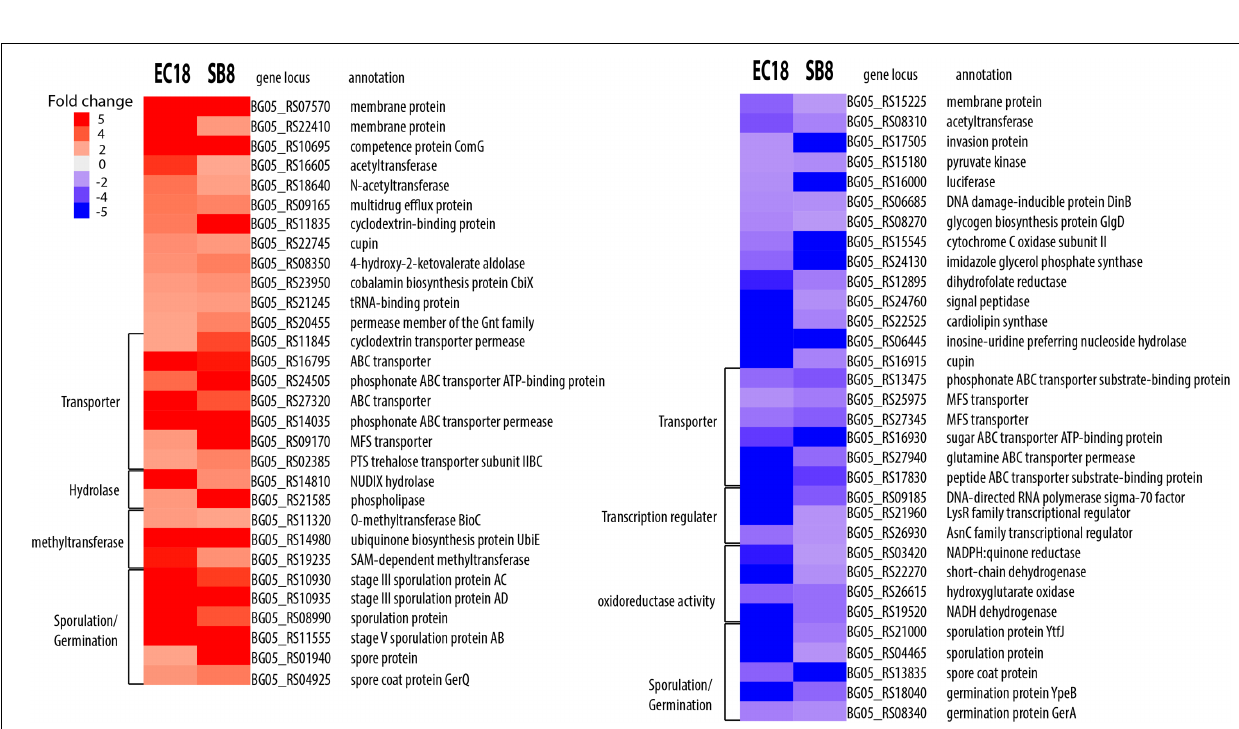
FIGURE 5 | Overlapping DEGs of B. mycoides strain EC18 and SB8 in response to root exudates. Red represents significant upregulation and blue indicates significant downregulation of gene expression.